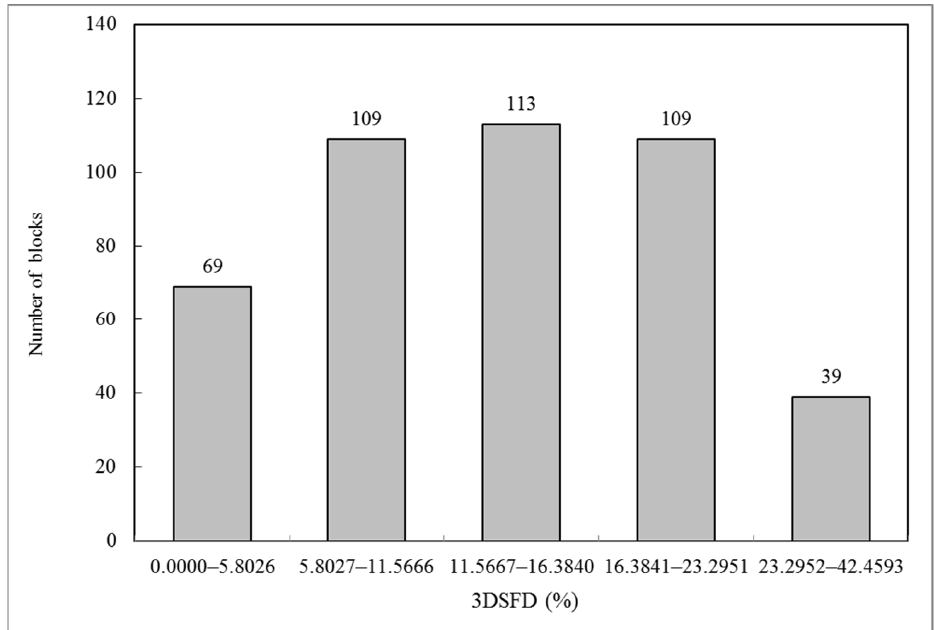
Figure 4. Descriptive statistics of 3DSFD in Kunming's Main Urban District by blocks.